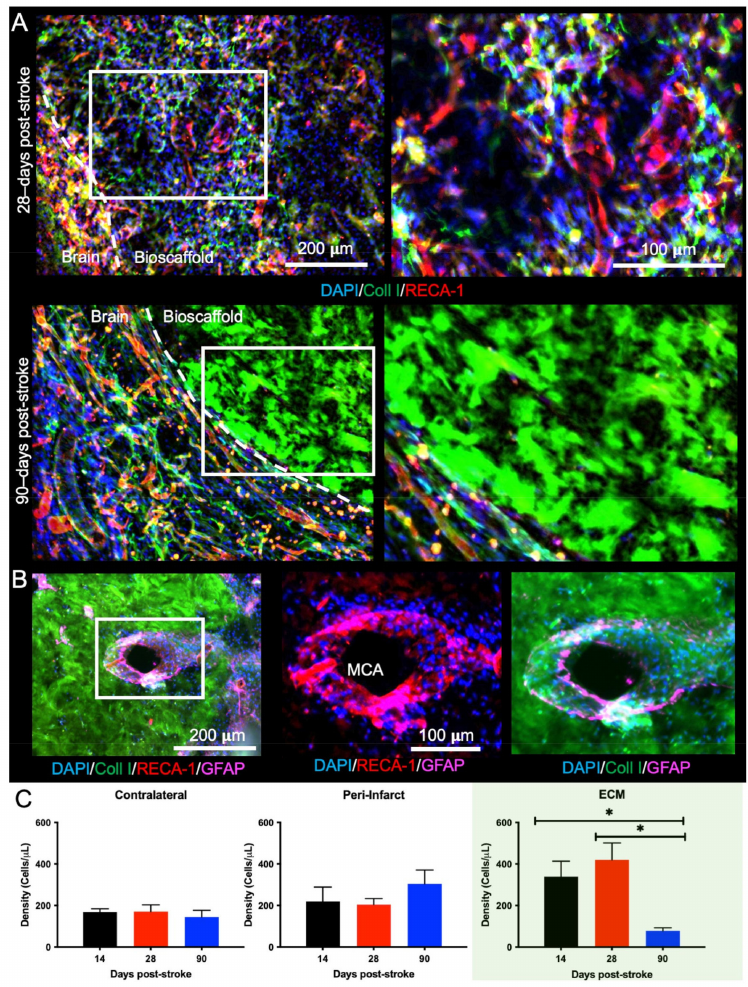
Figure 7. Neovascularization of the ECM hydrogel. ( A ) Neovascularization inside the hydrogel was evident if the ECM hydrogel underwent sufficient biodegradation, as illustrated here when the material was implanted 28-days post-stroke. However, there was a lack of vascular formation when the bioscaffold was implanted 90-days post-stroke, despite the number of blood vessels observed in the peri-infarct region. ( B ) The remnant of the middle cerebral artery (MCA) was surrounded by cells invading into the bioscaffold implanted 90-days post-stroke, illustrating one method of cell infiltration is for host cells to migrate along blood vessels. ( C ) A quantification of RECA-1+ cells indicated that the 90-days post-stroke condition had the lowest infiltration of endothelial cells (ECs) compared to the 14- and 28-days’ time points. The peri-infarct region presented with a slightly higher density of endothelial cells than the contralateral hemisphere across all time points (* p <